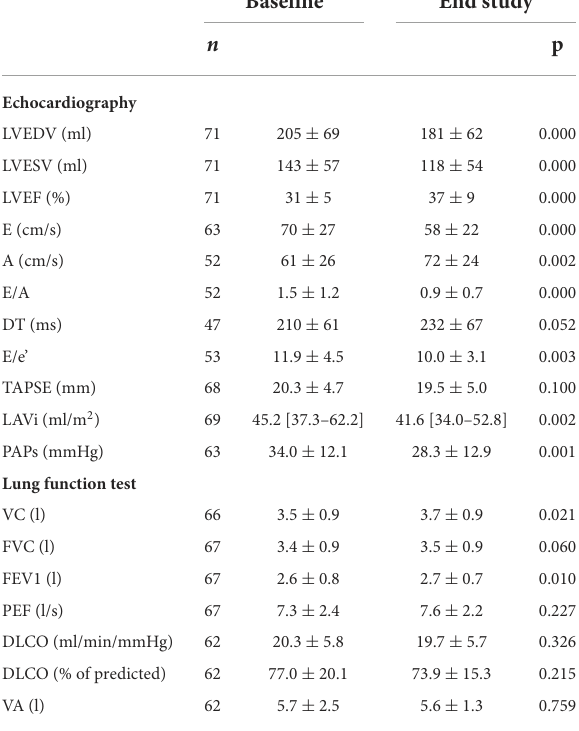
TABLE 2 Echocardiographic parameters and lung function comparison at baseline vs. end study.